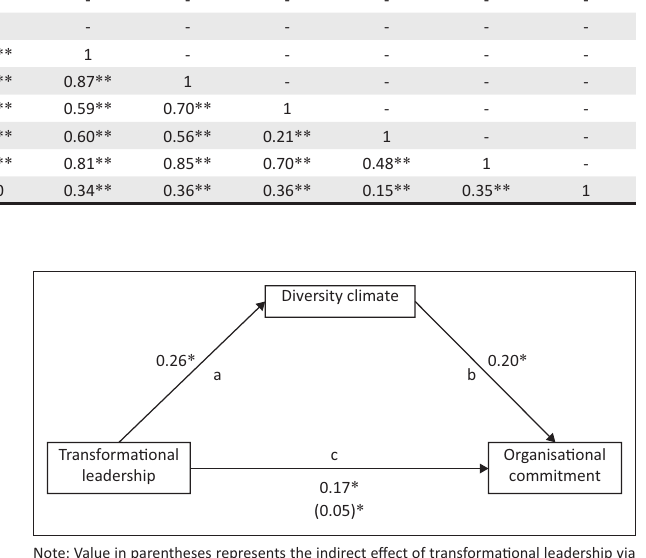
FIG URE 2: Simple mediation model: Transformational leadership to organisational commitment via diversity climate ( n = 230).